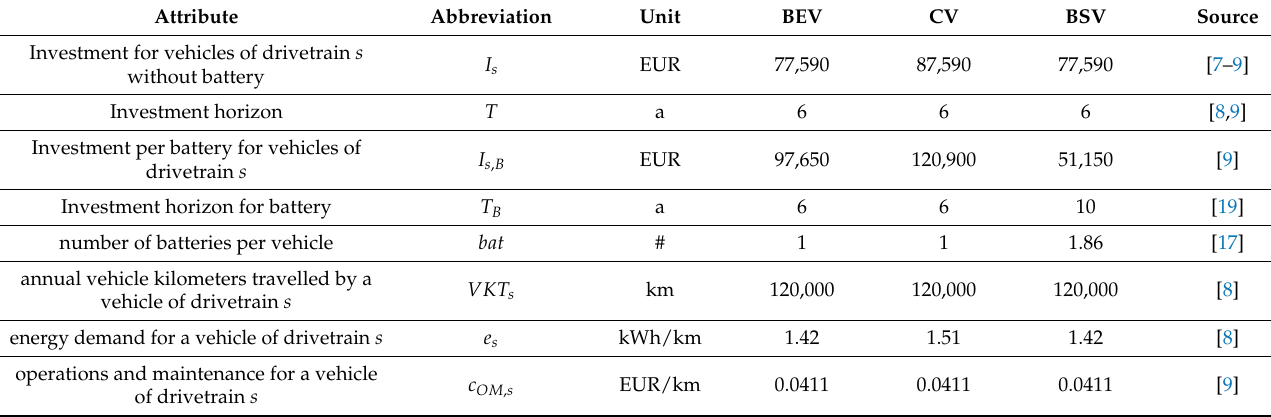
Table 3. Techno-economic vehicle